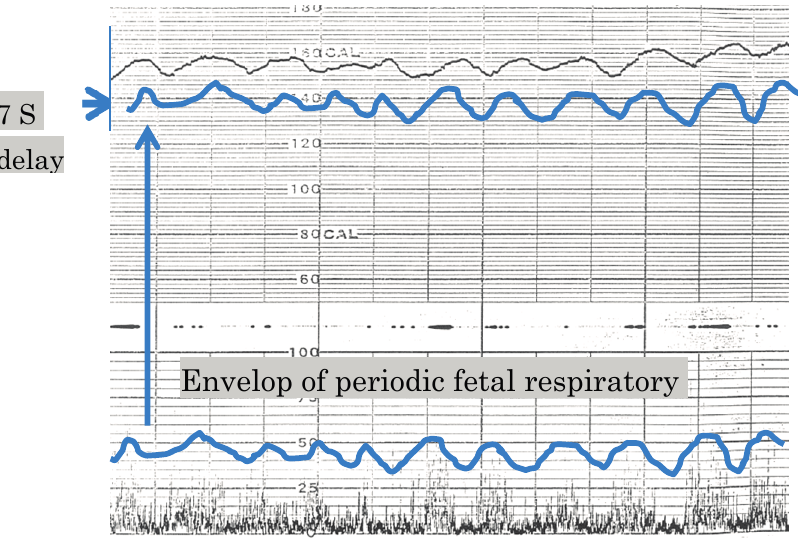
Figure 1. The most upper line is a benign physiologic sinusoidal fetal heart rate (FHR), and third lines recorded by actocardiogram (ACG). Since the outcome of